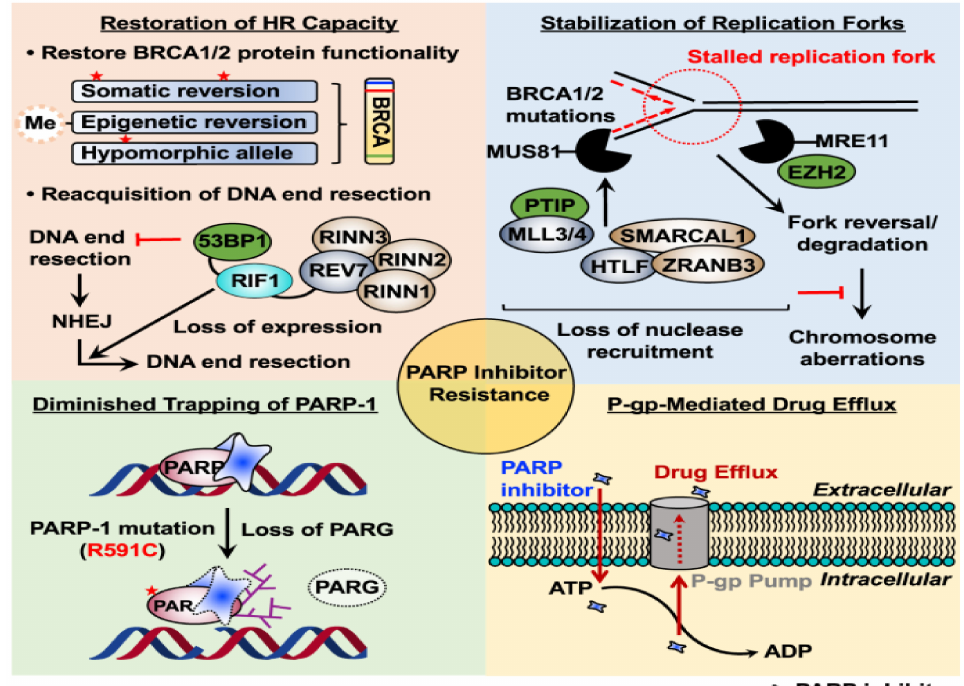
Figure 2. Mechanisms of resistance to PARP inhibitors. Cancer cells develop different resistance mechanisms that pose a significant obstacle to the prolonged use of PARPi. Several proposed molecular mechanisms of PARPi resistance, including restoration of HR capacity, stabilization of replication forks, diminished trapping of PARP-1, and P-gp-mediated drug efflux, are highlighted in four